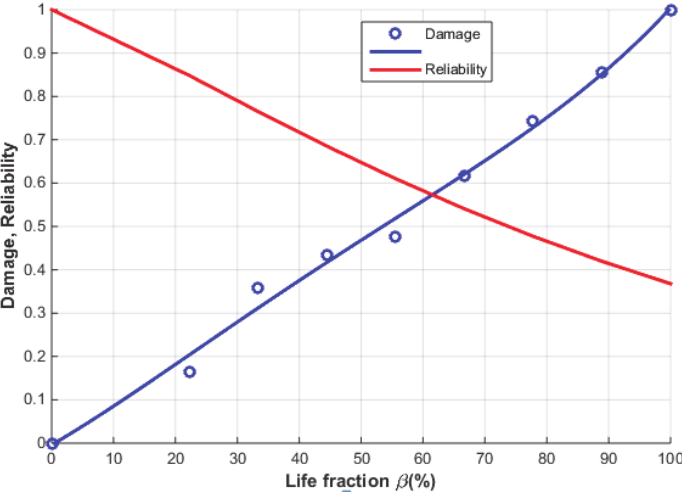
Figure 9: Damage-reliability curve as a function of life